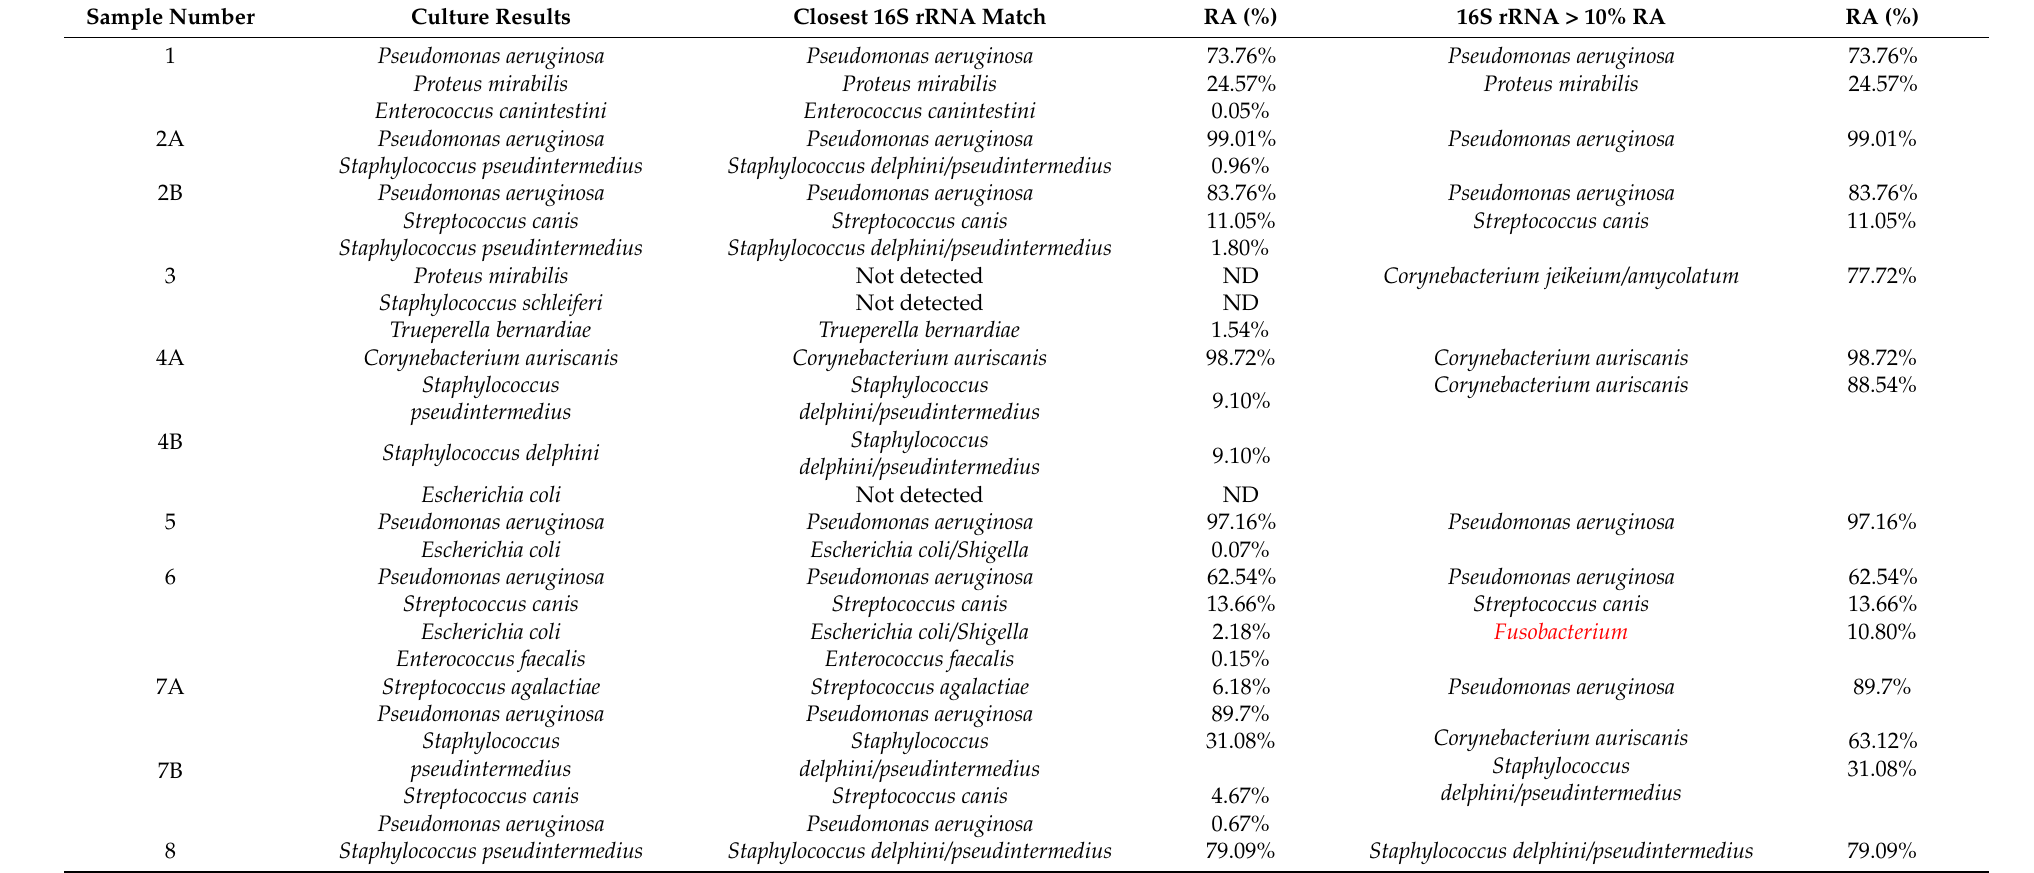
Table 3. Comparison of bacterial culture and 16S amplicon profiling results with their relative abundance (RA) of predominant OTUs. This table shows culture results and 16S rRNA for all samples. For each sample, the closest 16S rRNA matching the culture result and its relative abundance (RA) are described in % for each bacterium. Finally, all the bacterial species with a relative abundance above than 10% are represented in the last column in % for each sample. (Anaerobic species are given in